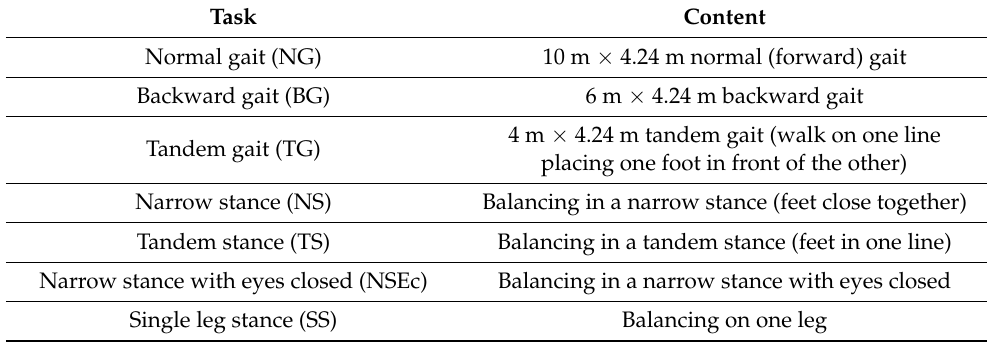
Table 1. Gait and balance